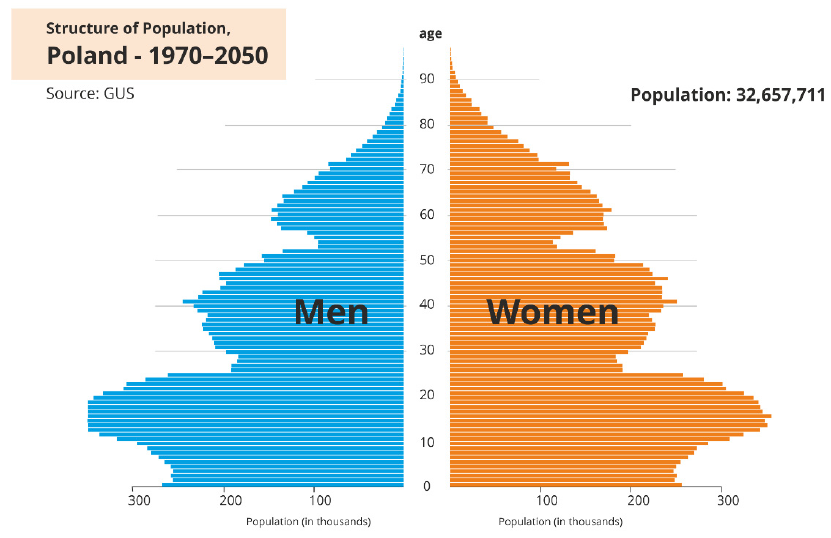
Figure 1. Population size in Poland [19].